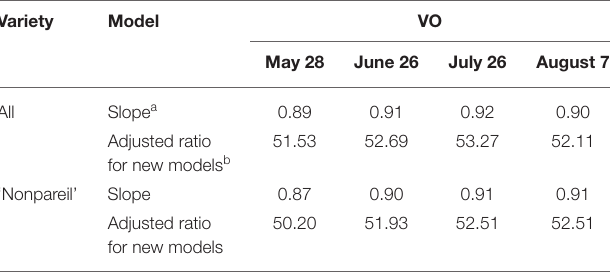
a Slopes are retrieved from Table 3 for each date. b Calculated using Equation